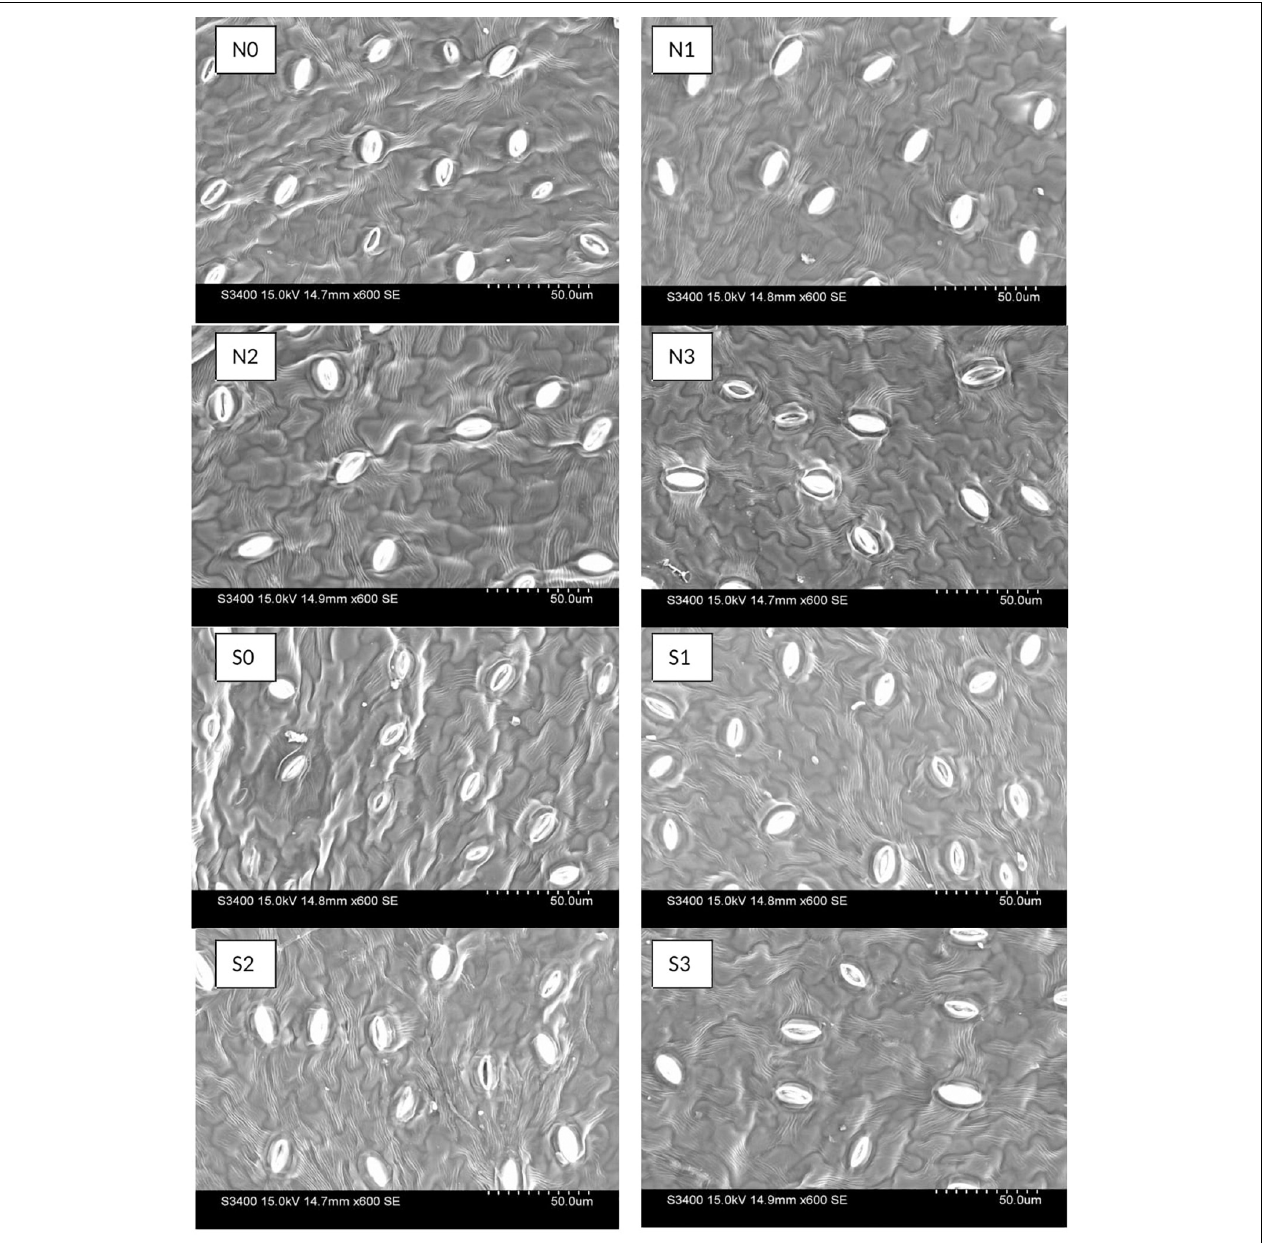
FIGURE 4 | Effect of nitrogen (N) and sulfur (S) fertilization levels on stomatal characteristics. N0, N1, N2, and N3 are the level of nitrogen @ 0, 60, 90, and 120 kg ha - 1 , respectively, while S0, S1, S2, and S3 are representing the level of sulfur @ 0, 20, 40, and 60 kg ha - 1 , respectively.